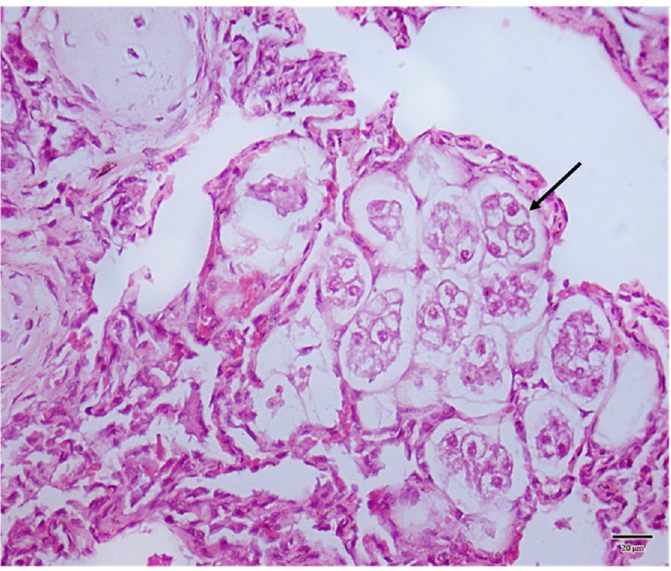
Figure 5. Histological section of the lung stained with hematoxylin-eosin. Parasitic eggs that fill the alveolar lumens are visible (arrow).